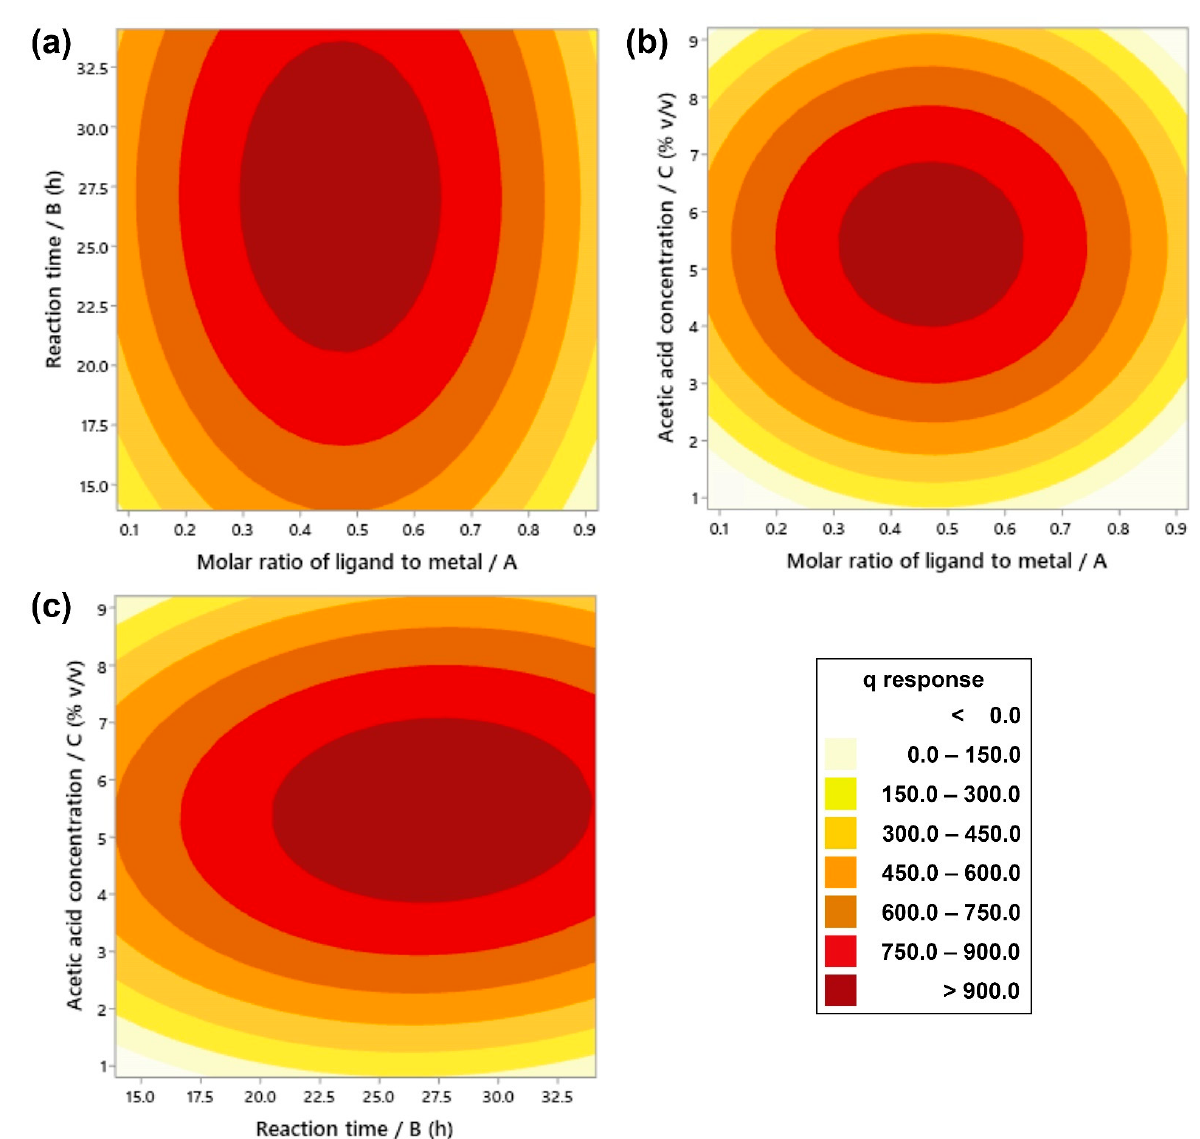
Figure 3. Contour plots showing the effects of two independent parameters by holding another parameter at the middle level: the effects of ( a ) molar ratio of ligand to metal and reaction time, ( b ) molar ratio of ligand to metal and acetic acid concentration, and ( c ) reaction time and acetic acid concentration.